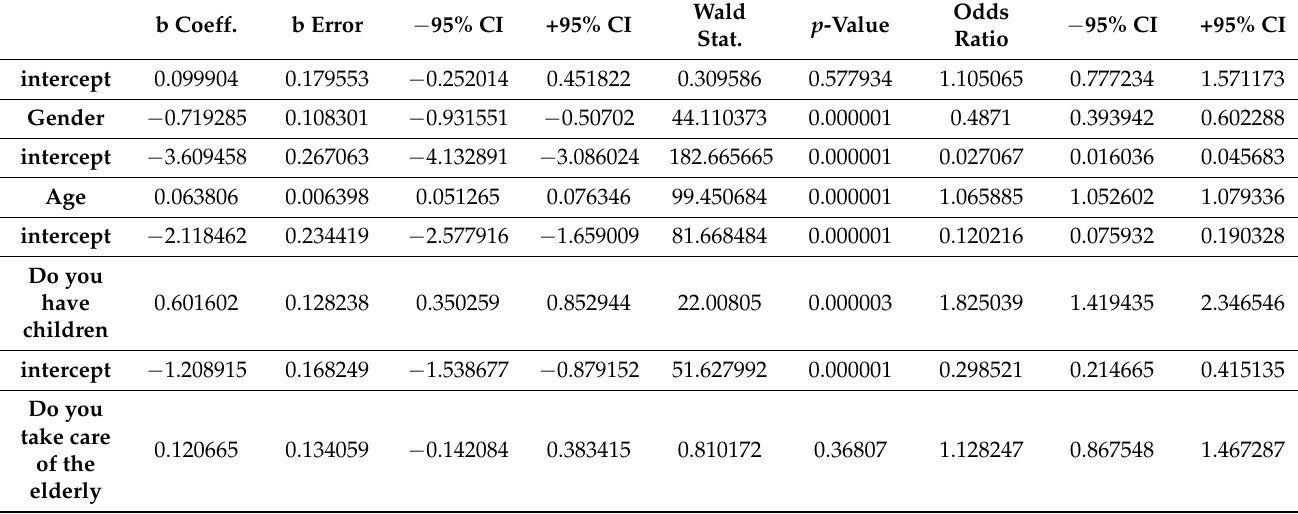
Table 5. Logistic regression model for psychological (mental) fear symptoms and demographics.